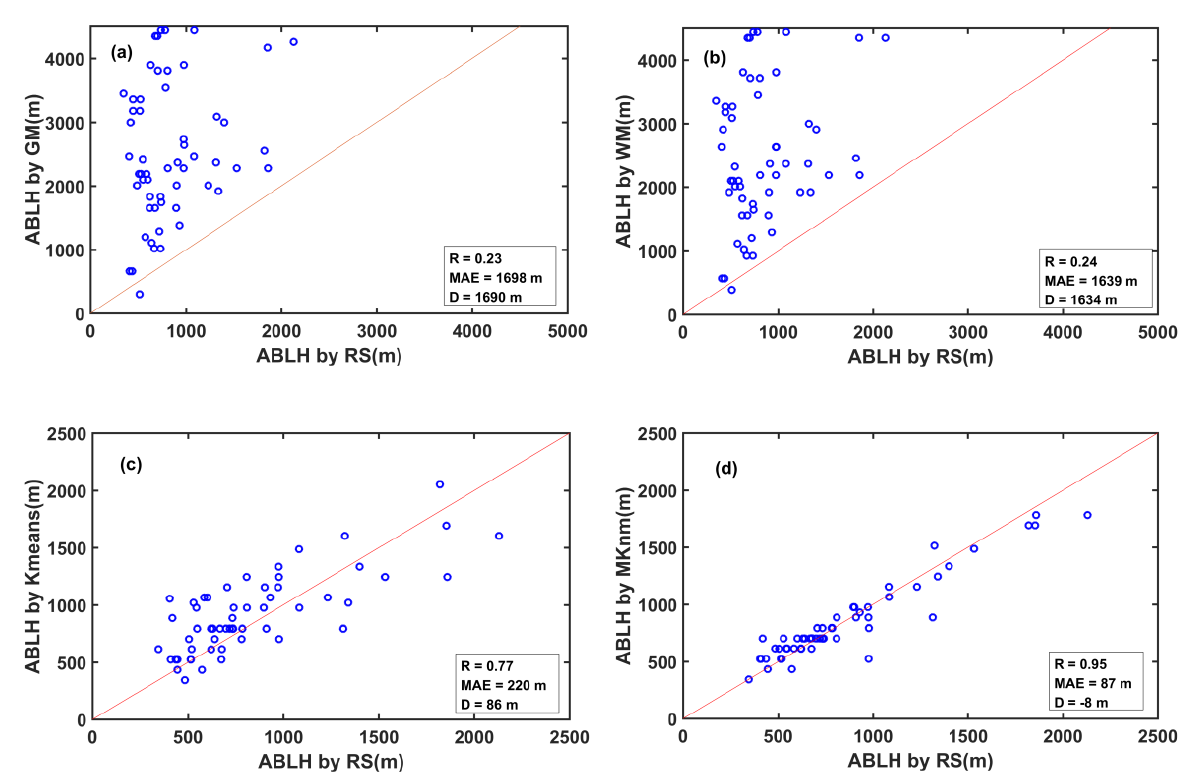
Figure 8. Comparisons between ABLH results determined by LiDAR-based methods and radiosonde for 56 cases in cloud or RL conditions. ( a ) GM and RS; ( b ) WM and RS; ( c ) Kmeans and RS; ( d ) MKnm and RS. The red dotted line is the expected 1:1 reference line. The correlation coefficient, mean absolute error and mean deviation are represented by R, MAE and D, respectively. Table 1. Correlation coefficients (R), mean absolute error (MAE), mean deviation (D) between ABLH determined by LiDAR-based methods and radiosonde.